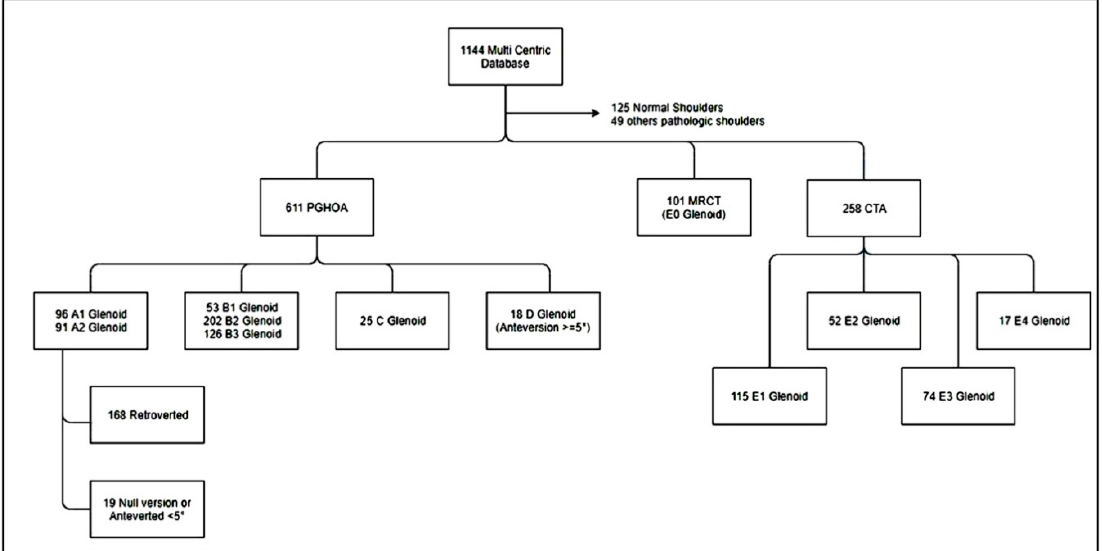
Figure 2. A flow chart of our database. Among a series of 1144 computer-tomographic (CT) scans, there were 258 cuff tear arthropathy (CTA) cases. The CTA group was divided in to 115 E1 glenoids, 52 E2 glenoids, 74 E3 glenoids, and 17 type E4 glenoids (6.5% of all CTA cases). primary gleno-humeral osteoarthritis (PGHOA): E0. E1-E4 corresponds to CTA (Cuff-Tear-Arthropathy), E0 corresponds to MRCT (Massive-Rotator-Cuff-Tears).